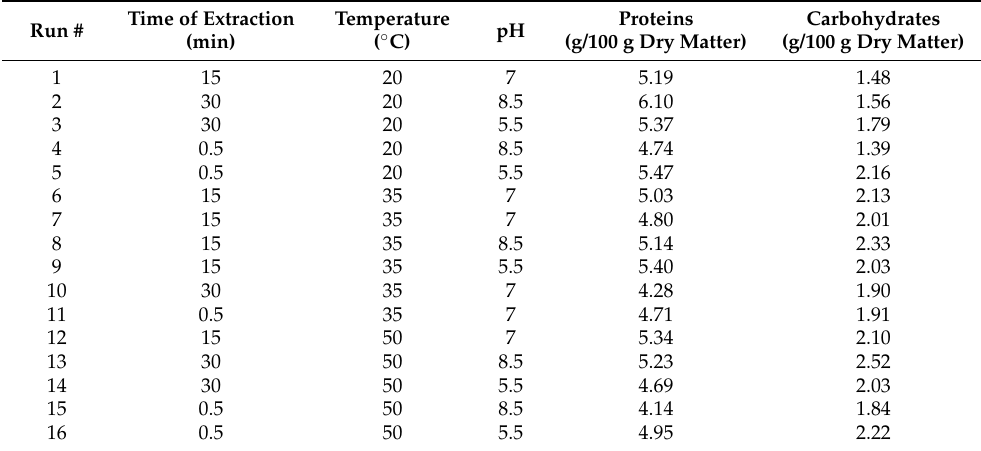
Table 2. Proteins and carbohydrates (g/100 g dry matter) obtained after ultrasound-assisted extrac- tion at different times, temperatures and pH